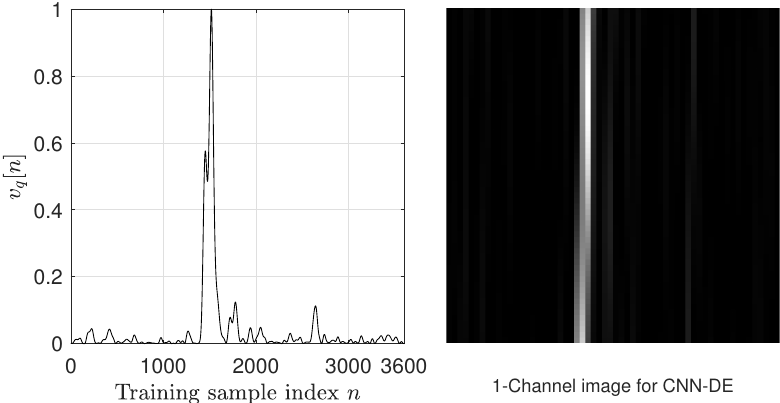
Figure 2. Example of the input for CNN-DE training of Rx- i . Here, the input sequence vector v i , q (the left subfigure) is generated from the received signals at Rx- i , and it has a length of 3600, i.e., N = 3600. One-channel input image matrix V i , q (the right subfigure) is 60 × 60, i.e., M =